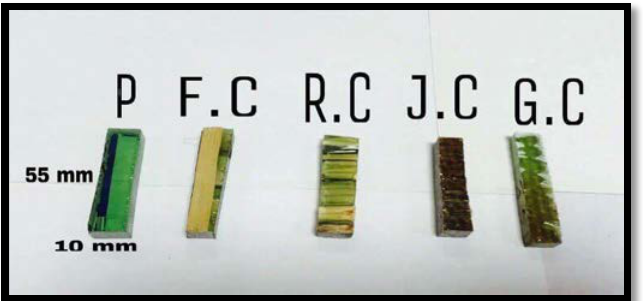
Fig. 1: Impact test samples before